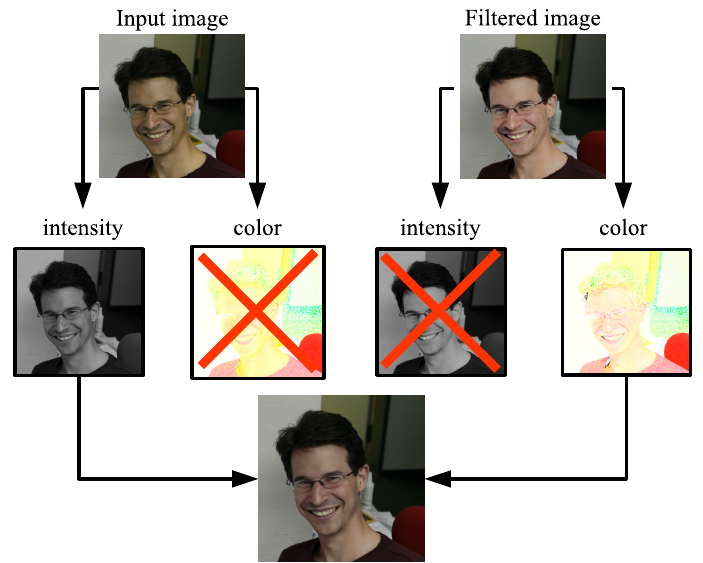
Figure 6. Simple luminance correction. Input image and filtered image are decomposed into intensity components and color components, respectively, by (16), then the intensity component of the input image and the color component of the filtered image are combined by (17).